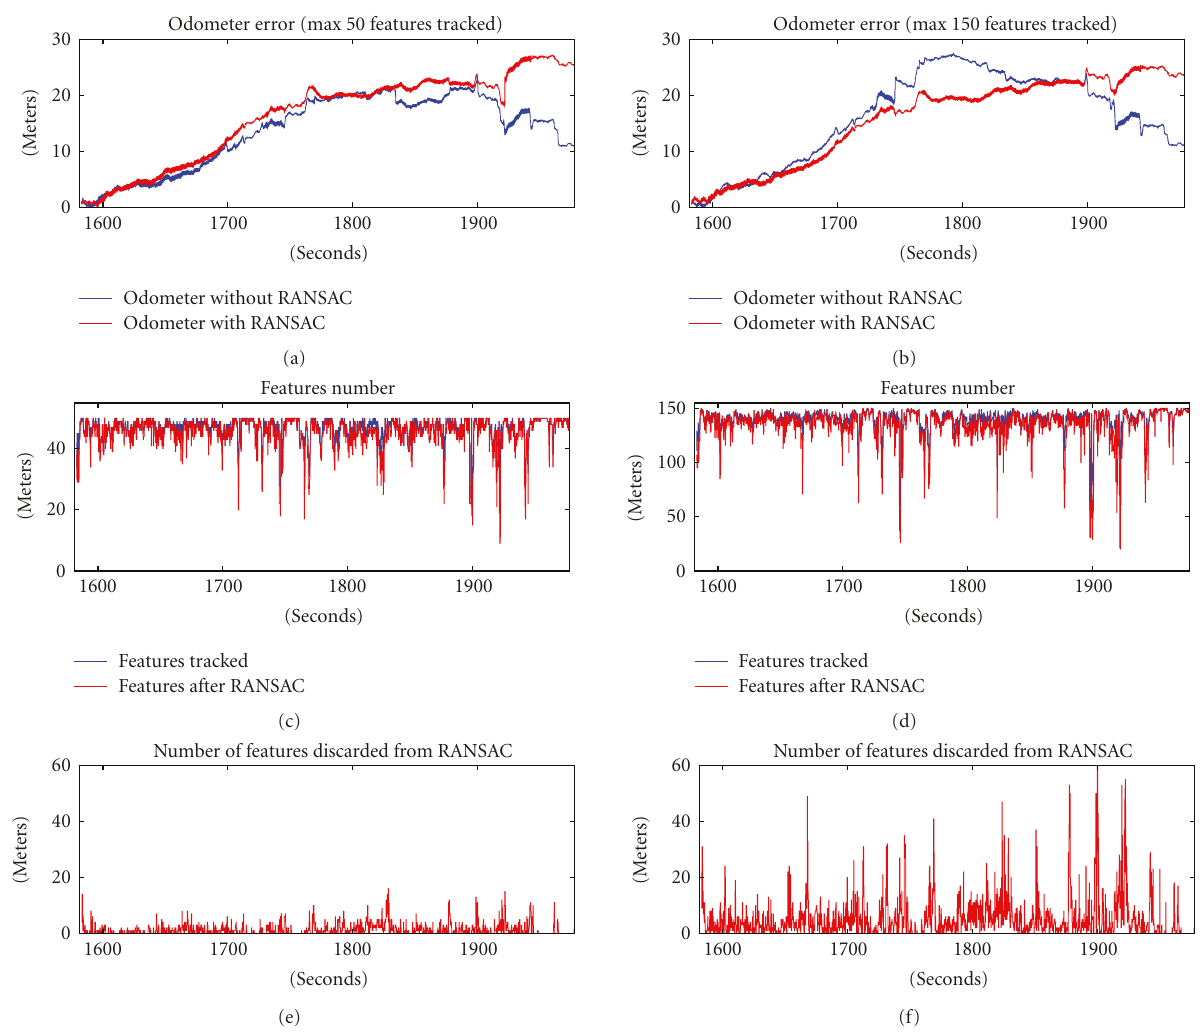
Figure 12: Comparison between odometry calculation using maximum 50 features (left column) and maximum 150 features (right column). The comparison also shows the e ff ects of the RANSAC algorithm on the odometry error.